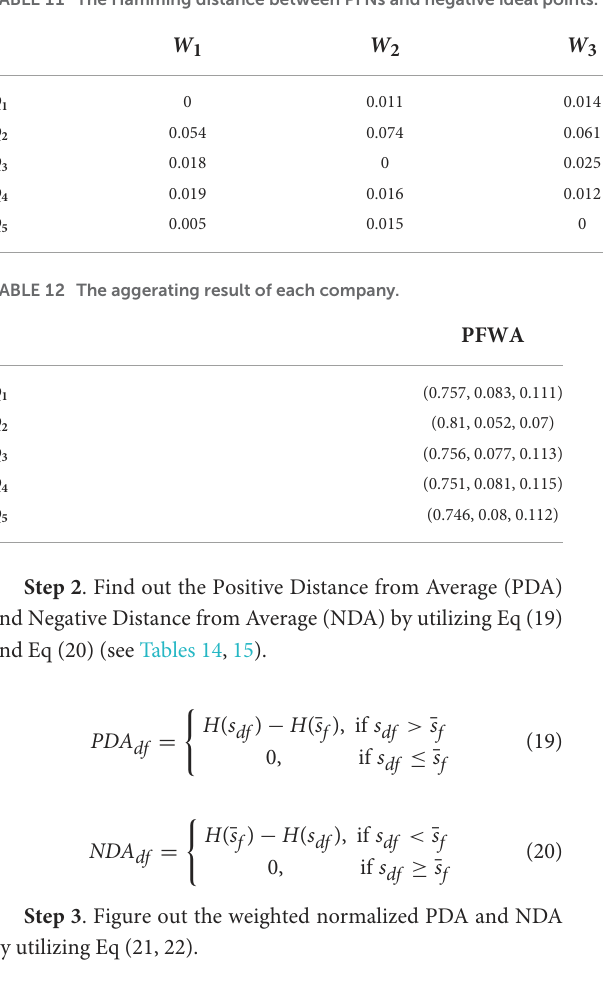
TABLE 11 The Hamming distance between PFNs and negative ideal points.